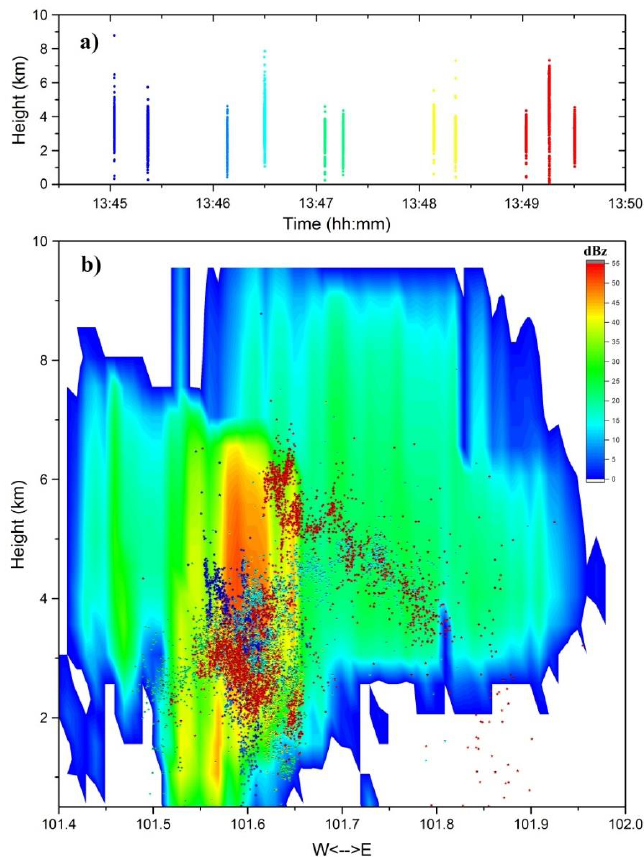
Figure 9. Superposition of the VHF radiation source positioning results and radar echoes (13:45–13:50). ( a ) Height-time plots; ( b ) North-Southward vertical projection superimposed by vertical section of